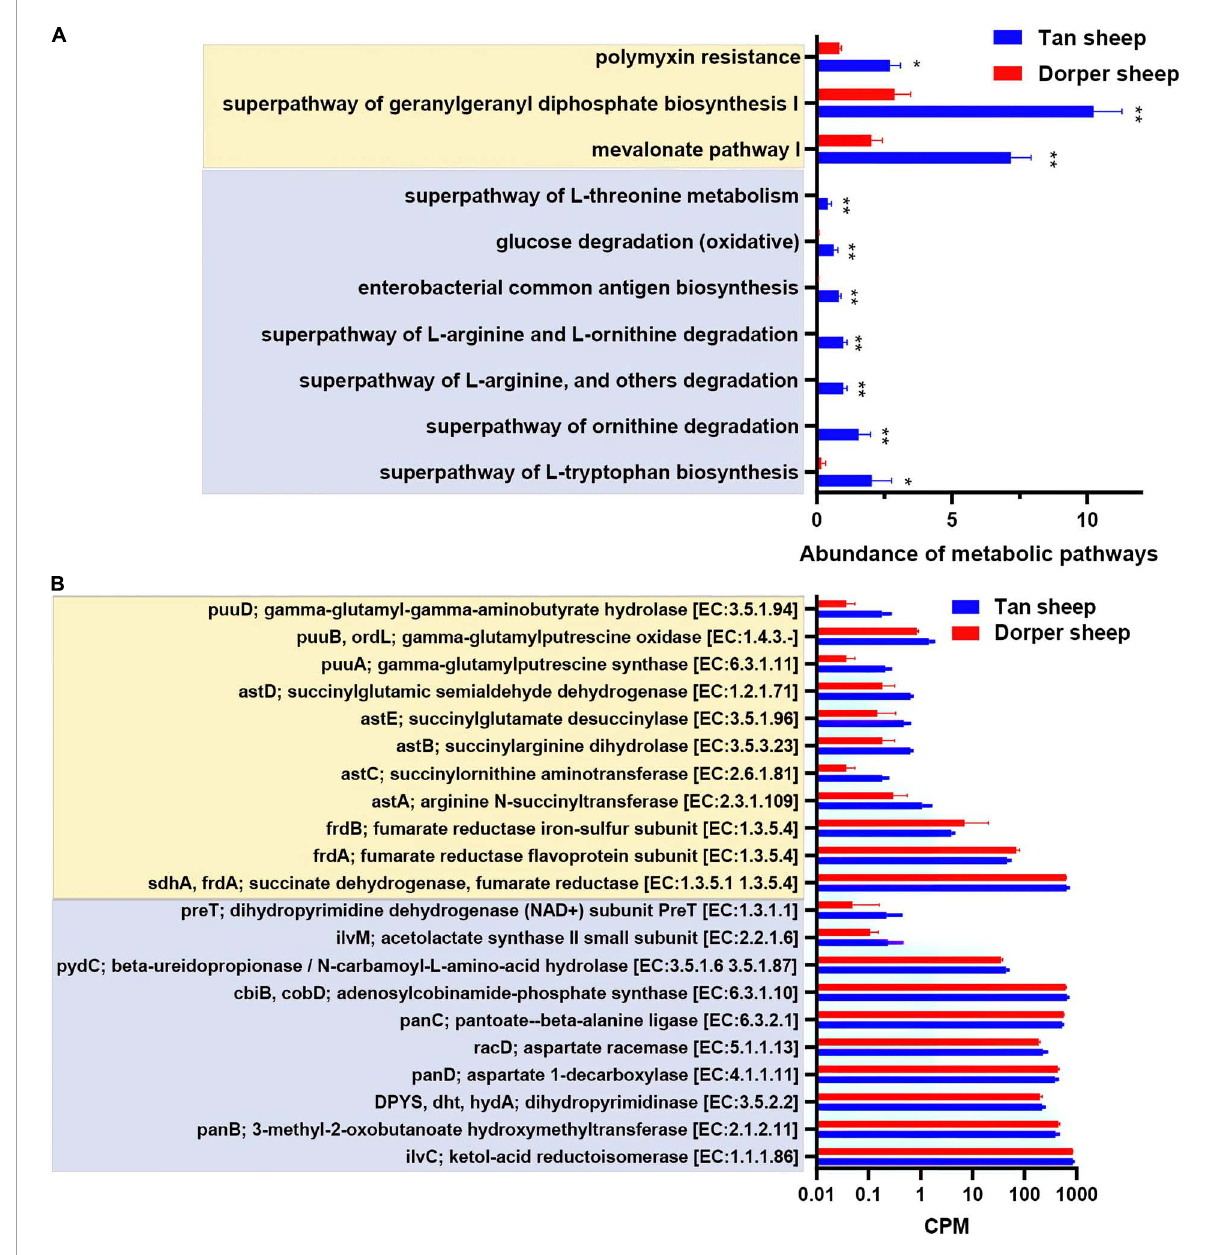
FIGURE4 Predictive analysis and statistics of foregut and hindgut microbial function. (A) The differential analysis of metabolic pathways based on the MetaCyc database (* P- value < 0.05, ** P- value < 0.01). (B) Critical metabolic enzyme enrichment based on the information of